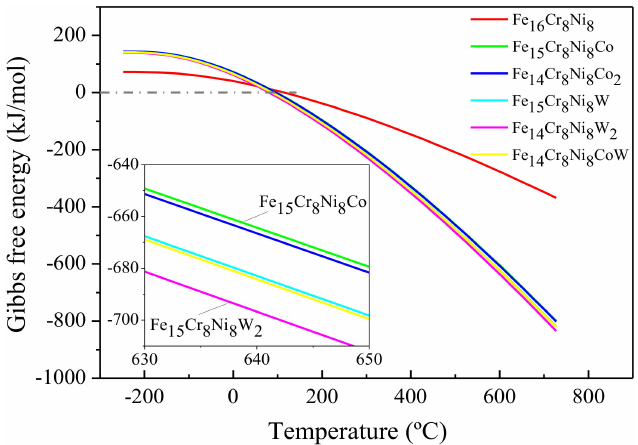
Figure 5. The relationships between Gibbs free energy and temperature in di ff erent systems.